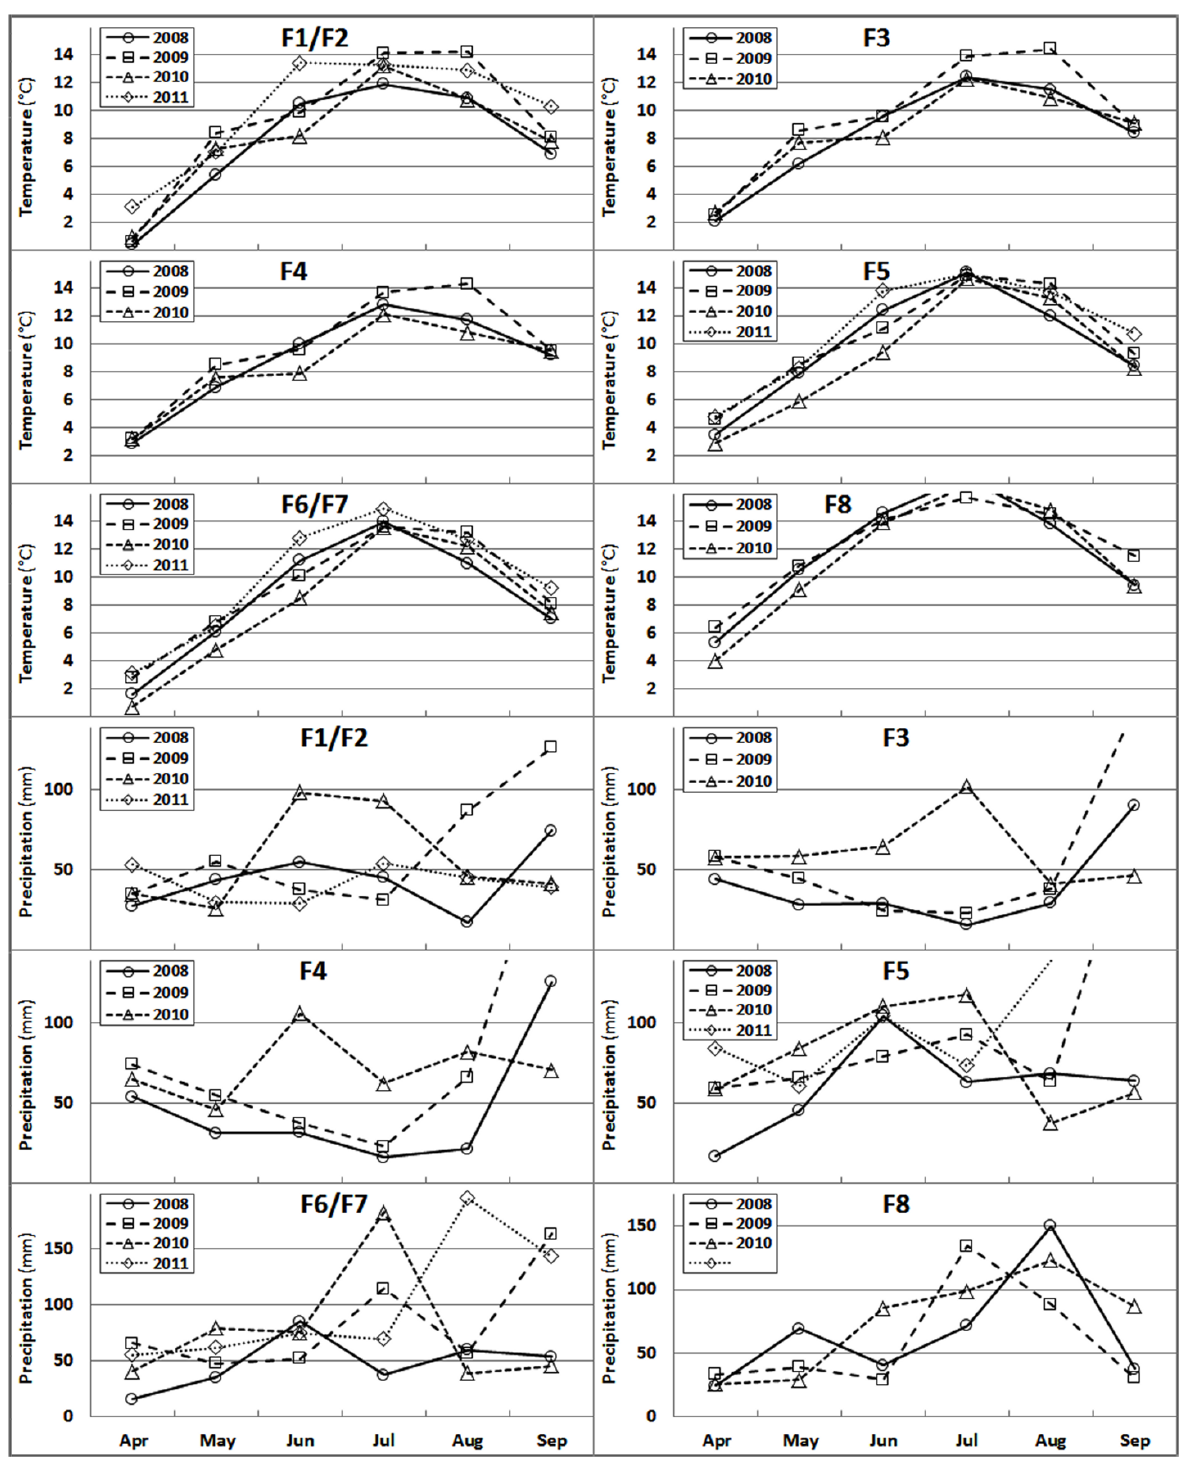
Supplementary Fig. S2: Monthly average temperature and precipitation data for all field locations throughout the growing season (April to September) from 2008 to 2011. F1/F2 (Sørdalen), F3 (Stornes), F4 (Leknes), F5 (Snåsa), F6/F7 (Lierne) and F8